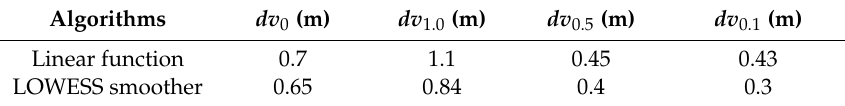
Table 1. Maximum deviations for original ( dv 0 ) and modified ( dv ∆ t )